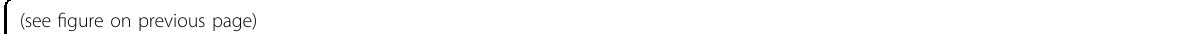
Fig. 1 SARS-CoV-2 N protein utilizes two components, the ITFG motif and RRM, to regulate G3BP1 phase separation. a Schematic diagram of SARS-CoV-2 N protein highlights an ITFG motif located in the N-IDR. IDR intrinsically disordered region. b GST – G3BP1 NTF2 pull-down of puri fi ed SARS-CoV-2 N 1 – 246 and ITFG mutants. c SARS-CoV-2 N 1 – 174 , but not N 1 – 30 or N 30 – 174 , is suf fi cient to inhibit phase separation of G3BP1 in the presence of RNA. Equimolar N fragment was mixed with MBP-G3BP1. TEV was added in solution to cleave the MBP fusion, and OD 575nm was recorded over time. Data represent mean±s.d. from 3 independent experiments. d Mutations in the ITFG motif of N protein impaired its ability to inhibit G3BP1- mediated phase separation. Experiments were performed similar to ( c ). e Summary of the phase separation behaviors of puri fi ed recombinant G3BP1 and RNA, in the absence of N protein or the presence of various N mutants. Red: no droplet; green: droplet. f Mutation of three basic amino acids (R92E/R107E/R149E, 3E) in the RRM domain of SARS-CoV-2 N protein signi fi cantly impaired the inhibitory effect of N protein on G3BP1 phase separation. g , h Overexpression of SARS-CoV-2 N protein inhibited the formation of SGs in cells, and mutation of the ITFG motif or RRM signi fi cantly abrogated the inhibition. Data shown in ( h ) represent mean ± s.d. from three independent experiments. Results were evaluated by one-way ANOVA test (** P < 0.01; *** P < 0.001; **** P < 0.0001; NS, not signi fi cant). Scale bar: 10 μ m. i Turbidity of G3BP1 with Caprin-1 or its mutants over time in the presence of RNA. Data represent mean ± s.d. from three independent experiments. j Turbidity of G3BP1 with Caprin-1 or N protein over time in the presence of RNA. Data represent mean ± s.d. from three independent experiments. k , l Caco-2 cells expressing N wild-type or mutants were infected with SARS-CoV-2 GFP/ Δ N trVLP, and cell culture supernatant was collected to infect Caco-2-N wild-type cells. GFP signal was observed using microscopy, and cellular RNA was extracted for RT-qPCR analysis to determine viral subgenomic RNA levels. Data represent mean ± s.d. from three independent experiments. * P < 0.05; ** P < 0.01; *** P < 0.001; **** P < 0.0001. Signi fi cance assessed by one-way ANOVA. Scale bar: 100 μ